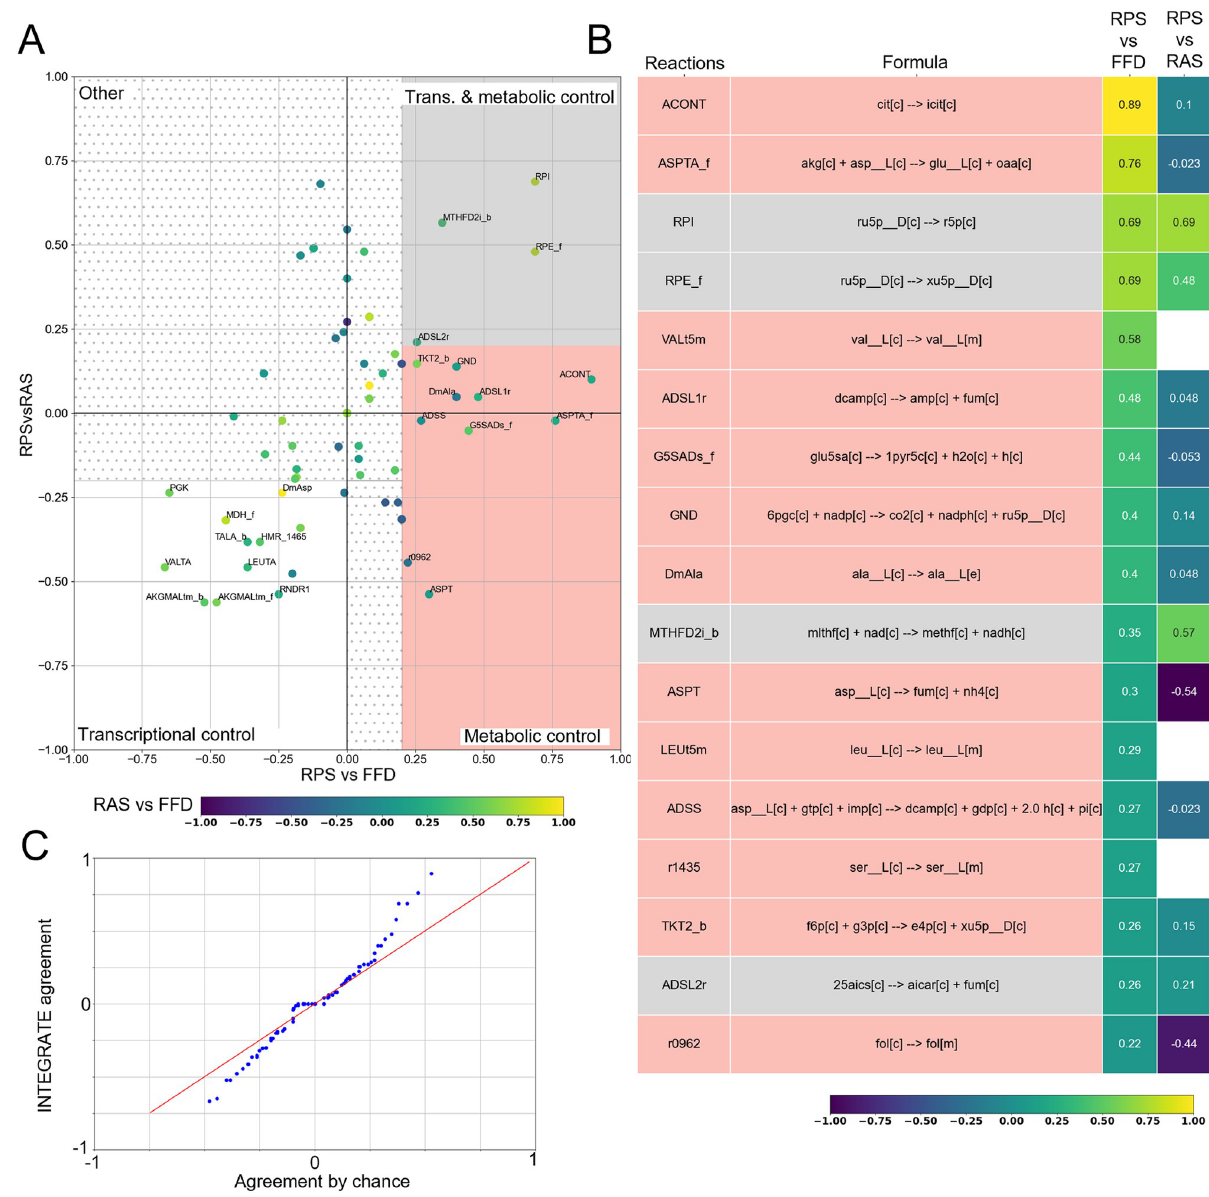
Fig 4. Variation concordance analysis. A) RPSvsFFD (x-axis) and the RPSvsRAS (y-axis) scores of the 81 metabolic reactions for which quantification of all substrate abundances was available. The points are coloured as a function the RASvsFFD scores. We reported the names of the reactions having at least one of the scores greater than 0.2 (i.e. fair concordance). B) Heatmap showing the RPSvsRAS and the RPSvsFFD concordance scores, for reactions having a level of concordance between RPS and FFD greater than 0.2. C) Q − Q plot between the empirical probability of agreement between two independent datasets and INTEGRATE Cohen’s kappa distribution related to the comparison between RPS and